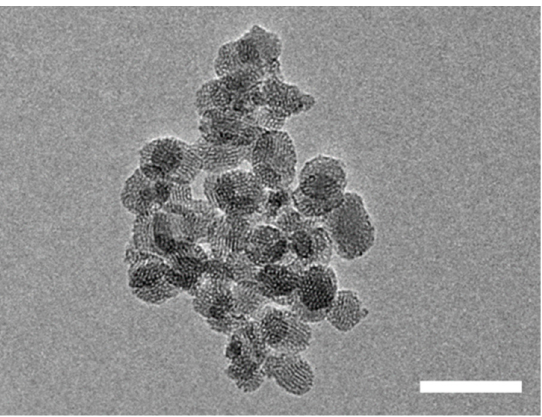
Figure 2. TEM image of the MSNs, with ordered pore structure and an average diameter of (45 ± 9) nm (obtained from the analysis of 50 particles in TEM images). Scale bar = 100 nm.